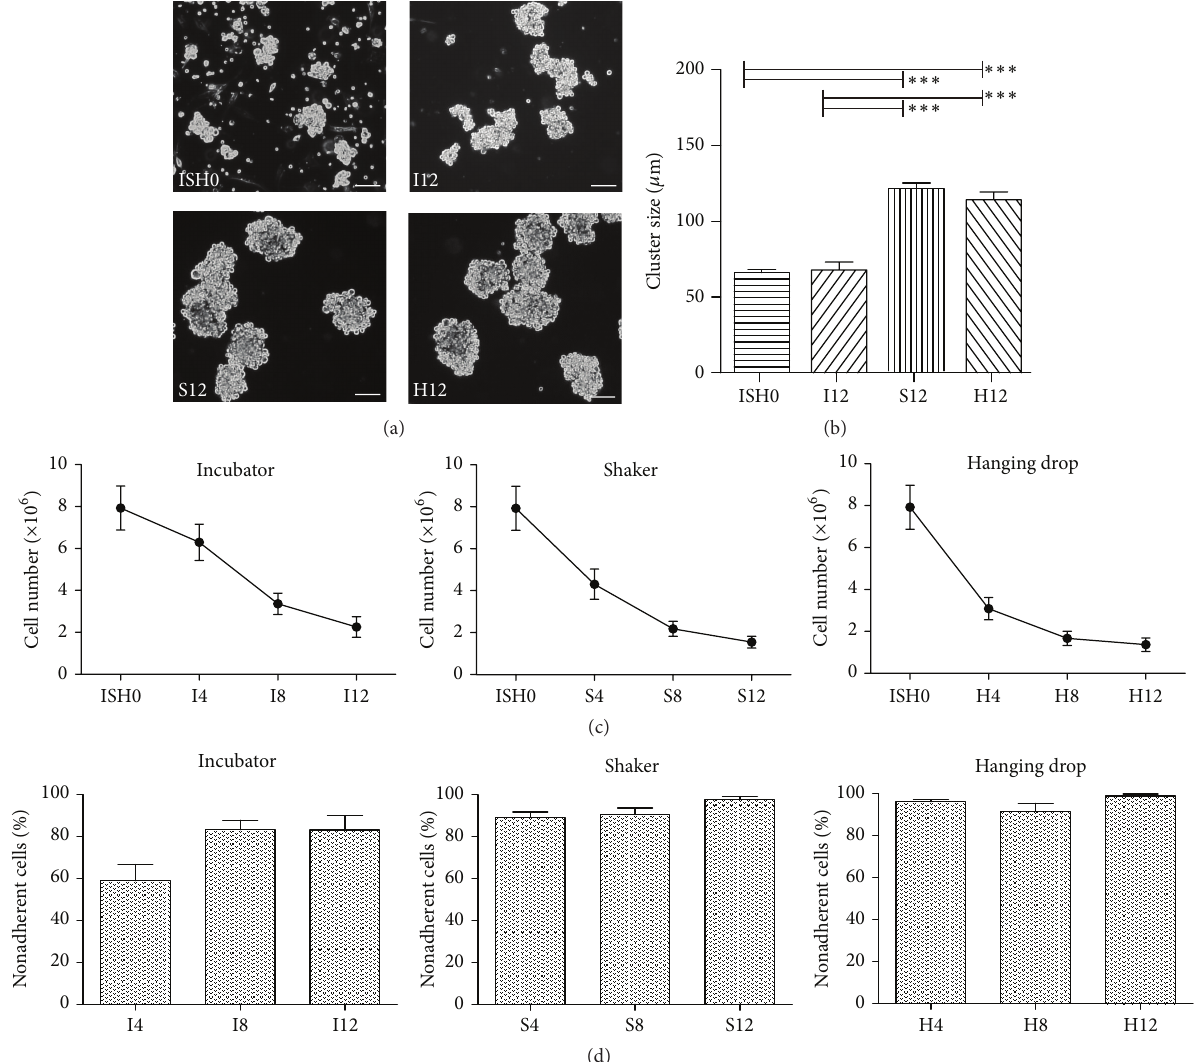
Figure 2: Characteristics of cell clusters derived from MDSCs. (a) Representative phase contrast microphotographs of cell clusters from different cell culture conditions. While single contracting cells and smaller clusters were visible in ISH0 cultures, most cells were organized in clusters of loosely attached cells applying static (I) and dynamic (S and H) culture conditions at day 12 of cultivation (I12, S12, and H12). Scale: 100 𝜇 m. (b) Average sizes of clusters in initial ISH0 cell populations and after twelve days applying different culture conditions. ∗∗∗ 𝑝 < 0.001 . (c) Total numbers of nonadherent cells obtained from muscles of 10 neonatal mice over the course of 12 days applying different culture conditions ( 𝑛 = 12 ). (d) Ratios of nonadherent cells over the course of 12 days applying different culture conditions ( 𝑛 = 12